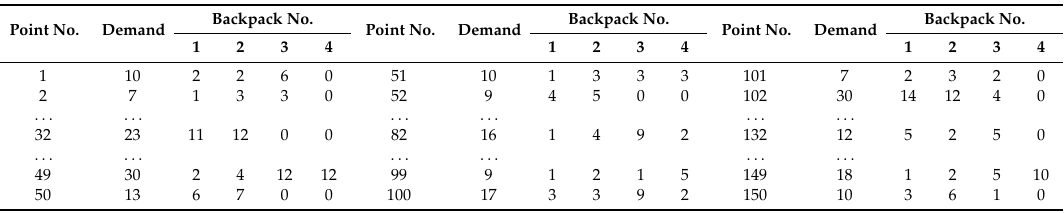
Table 2. The customer demand data of a4.